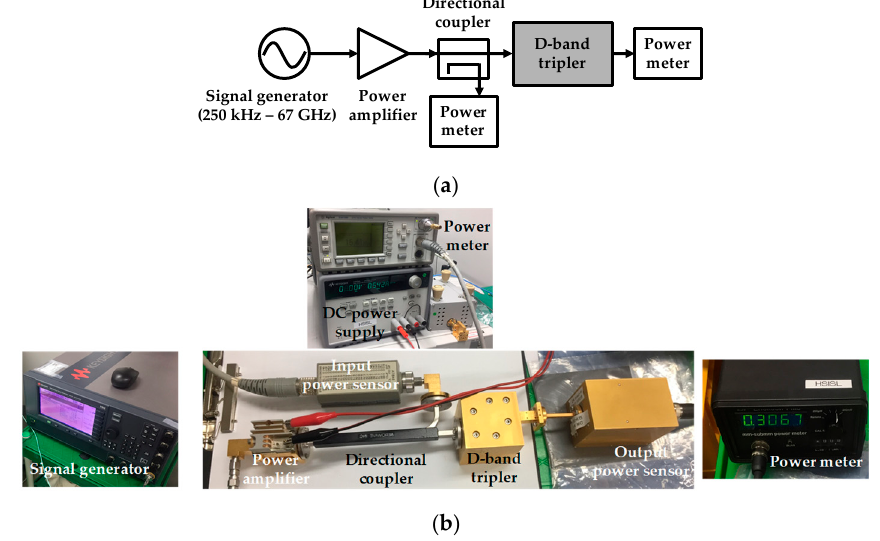
Figure 13. Measurement set ‐ up of D ‐ band frequency tripler. ( a ) Block diagram and ( b ) photograph.